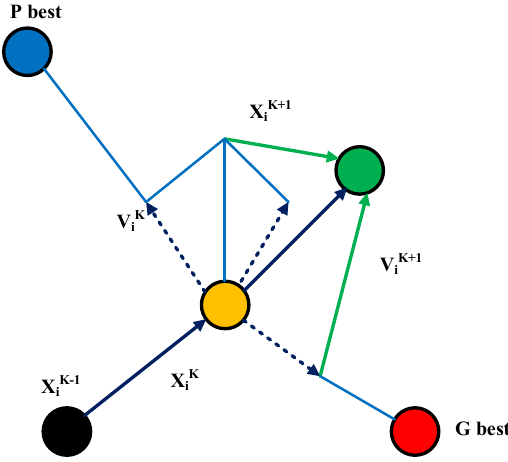
Figure 12. Particle movement in search space for